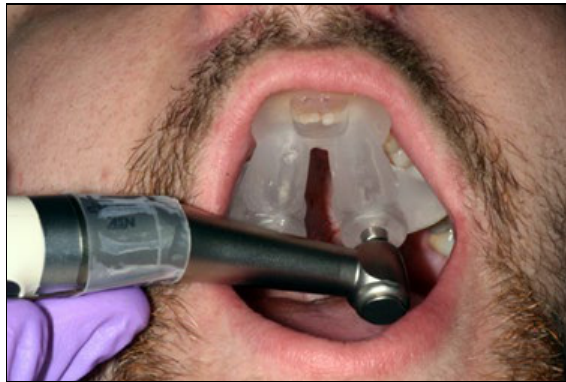
Figure 3. Guided insertion using a pre-fabricated splint.